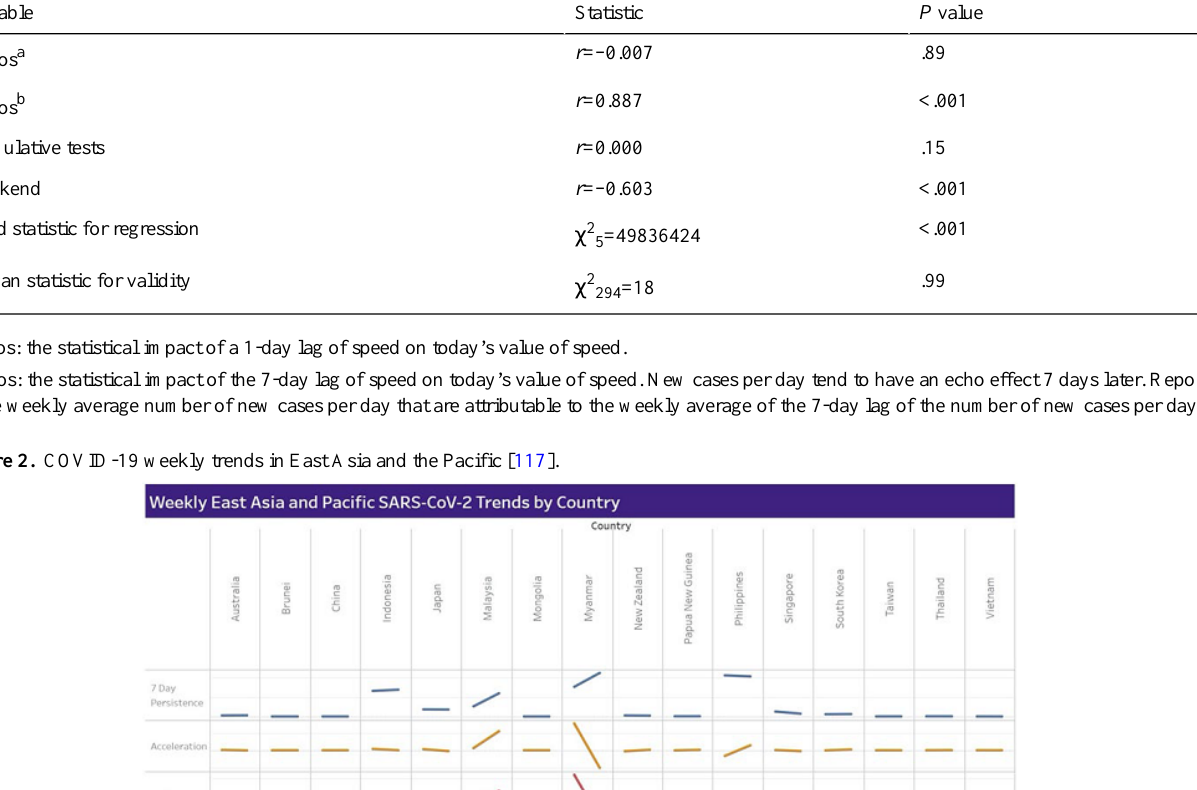
and Figure 2 [117] are based on these regressions. The Wald statistic for the regression was significant ( χ 2 =49,836,424; P <.001). The Sargan test was not significant, 5 failing to reject the validity of overidentifying restrictions ( χ 2 =18; P =.99). 294 P valueStatisticVariable